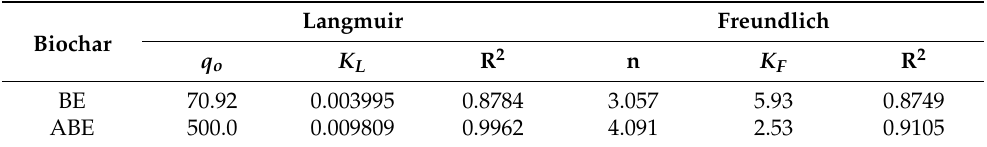
Table 2. Adjustment to Langmuir and Freundlich isotherm model for biochar (BE) and activated biochar